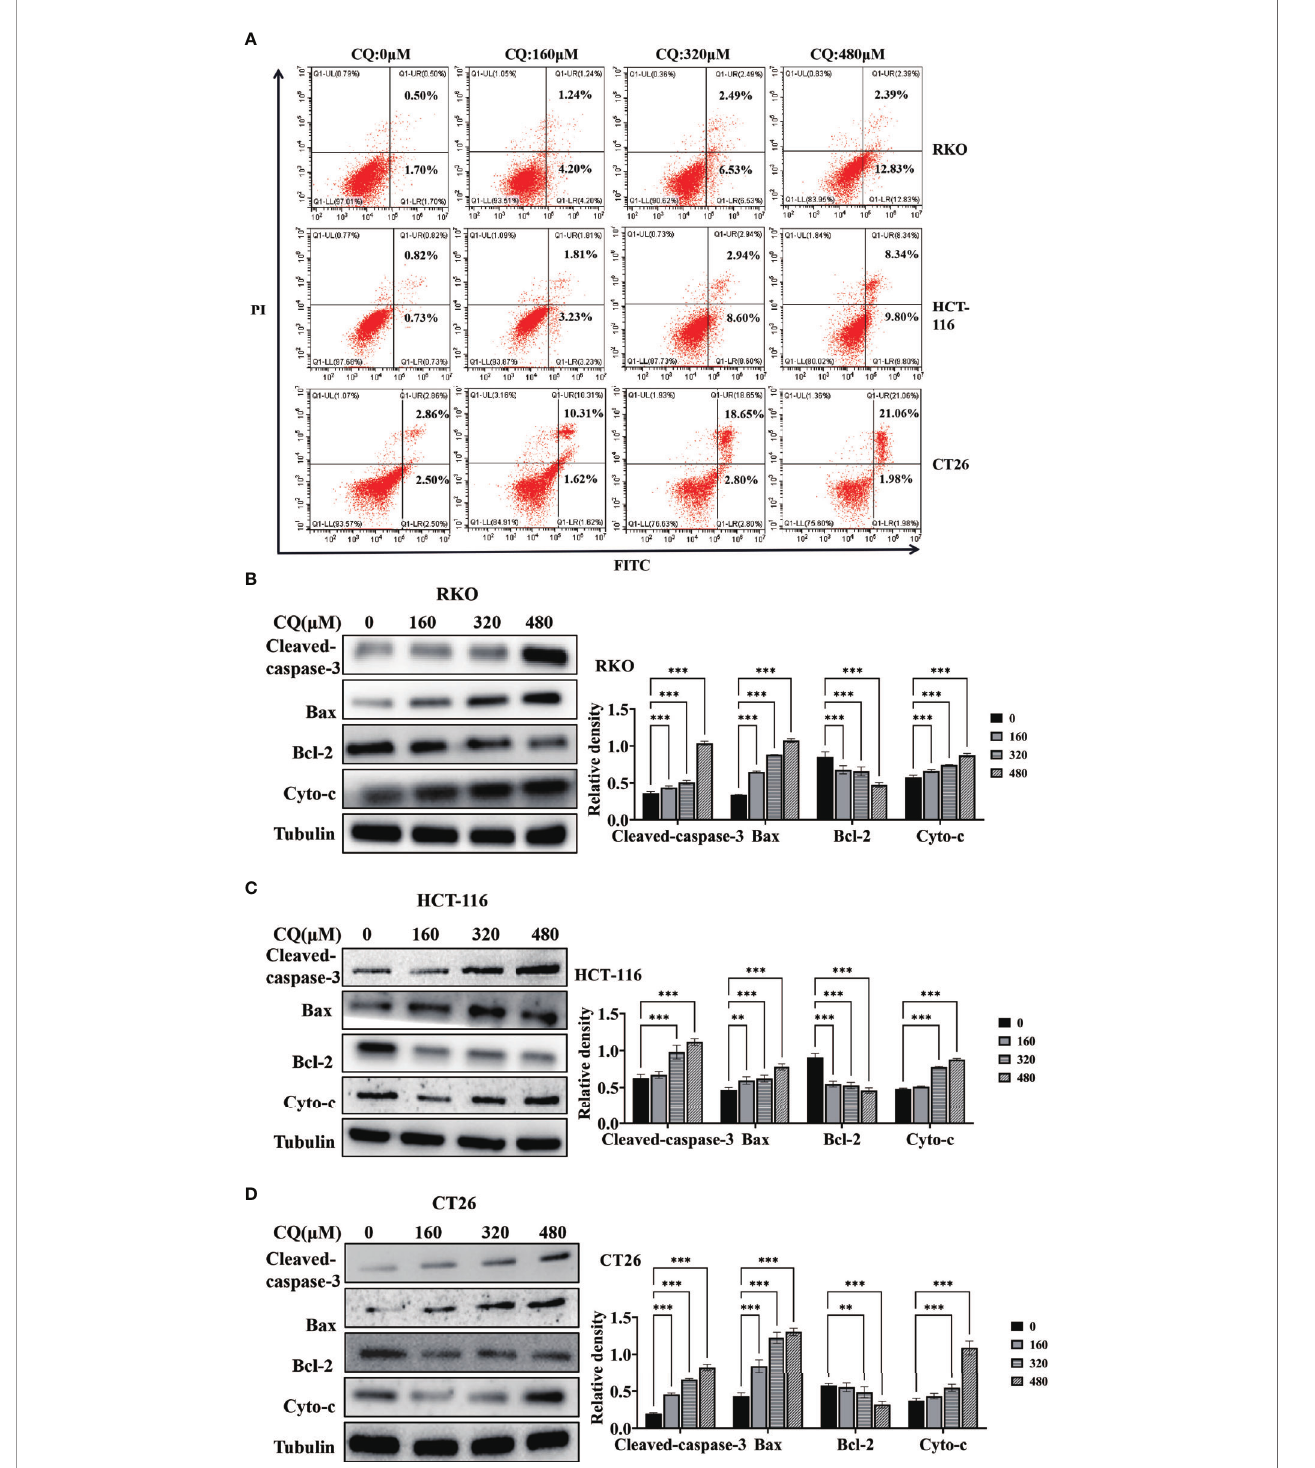
FIGURE 2 | Chloroquine induces apoptosis of colorectal cancer cells and affects the expression of related proteins. (A) Flow cytometry detected the apoptotic rate of RKO, HCT-116 and CT26 induced by CQ. (B – D) Western blotting analysis for the protein expression of Cleaved caspase 3, Bax, Bcl-2 and Cytochrome c (Cyto-c) after treatment with a chain of concentrations of CQ. (** p < 0.01, *** p < 0.001 vs 0 m M